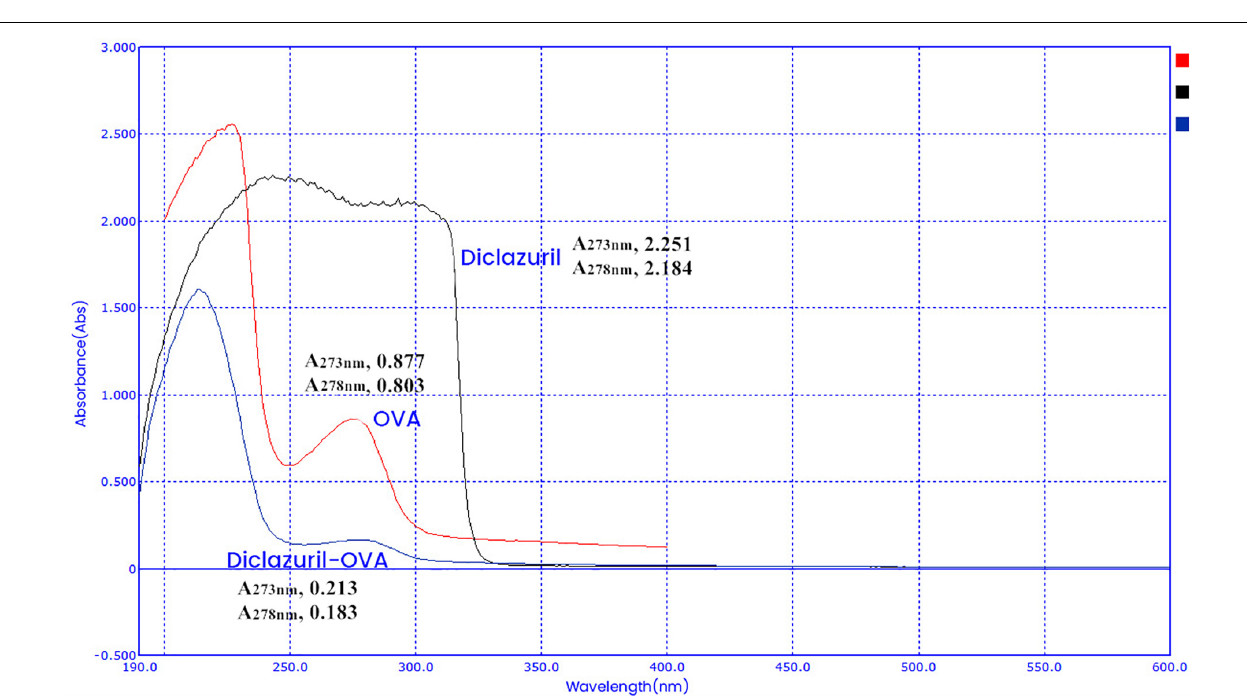
FIGURE 3 | UV scanning spectroscopy of the diclazuril-ovalbumin (OVA) conjugate.